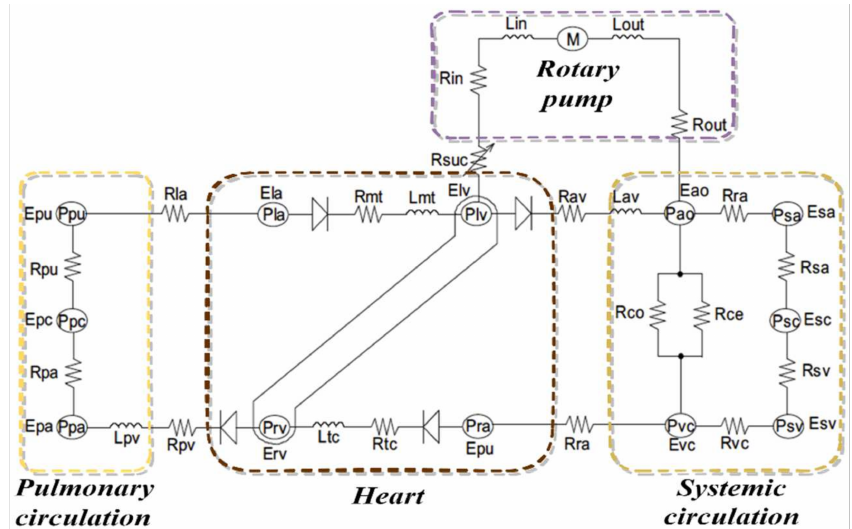
Figure 3. Electrical equivalent circuit analogue of CVS–LVAD interaction. R in : inlet cannula resis- tances; R out : outlet cannula resistances; L in : inlet cannula inertances; L out : outlet cannula inertances; R suc : suction resistance; and P thor 1 and P thor 2 : intrathoracic pressures.